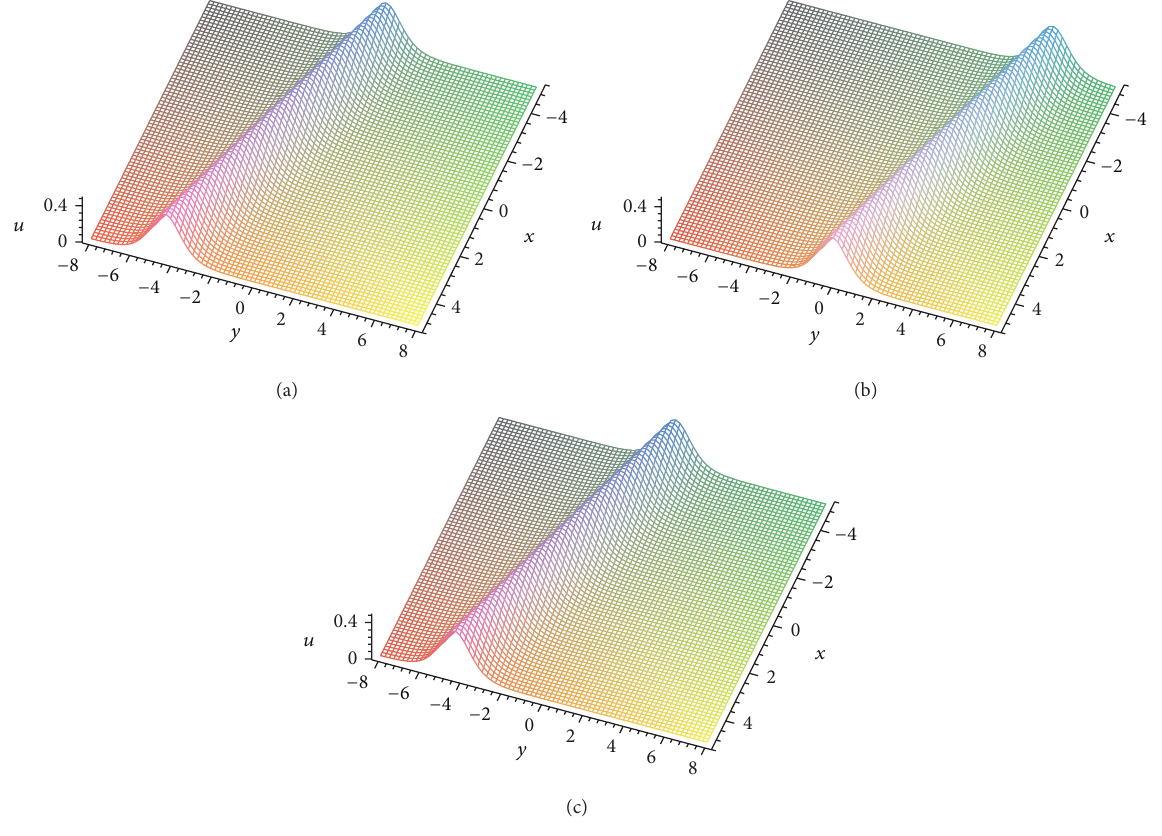
Figure 1: One-soliton solution via solution (32) with 𝑎 9 = 0.01 , 𝑘 1 = 1 , 𝑙 1 = 2 , 𝑐 0 = 1 , 𝑐 1 = 1 , 𝑎 1 = sin (𝑡) , and 𝜉 1 = 0 . (a) 𝑡 = −2 ; (b) 𝑡 = −1 ; (c) 𝑡 = 2